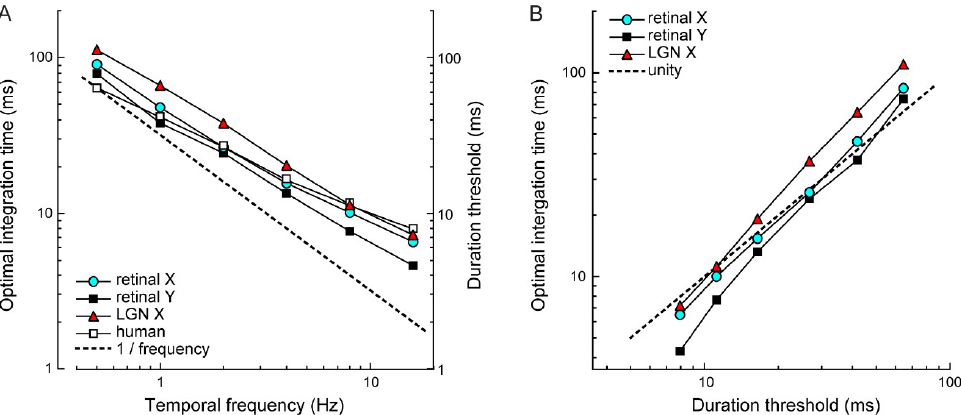
Figure 6. Similar stimulus dependence of optimal integration times and human duration thresholds.